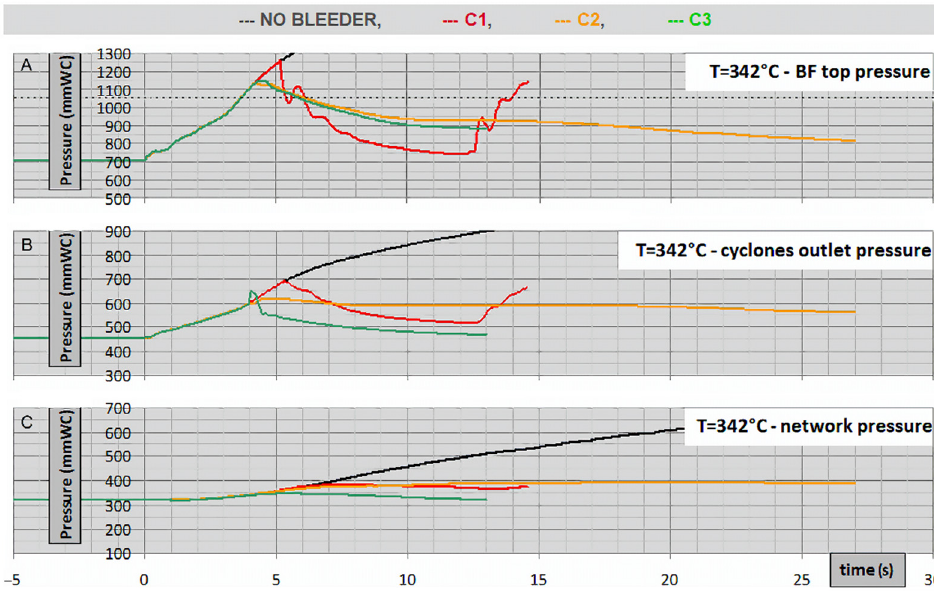
Figure 13. Evolution over time of pressure in the three different circuits C1, C2 and C3 compared with the no bleeders case in a high severity event. A: BF top pressure; B: cyclones outlet pressure; C: network pressure.